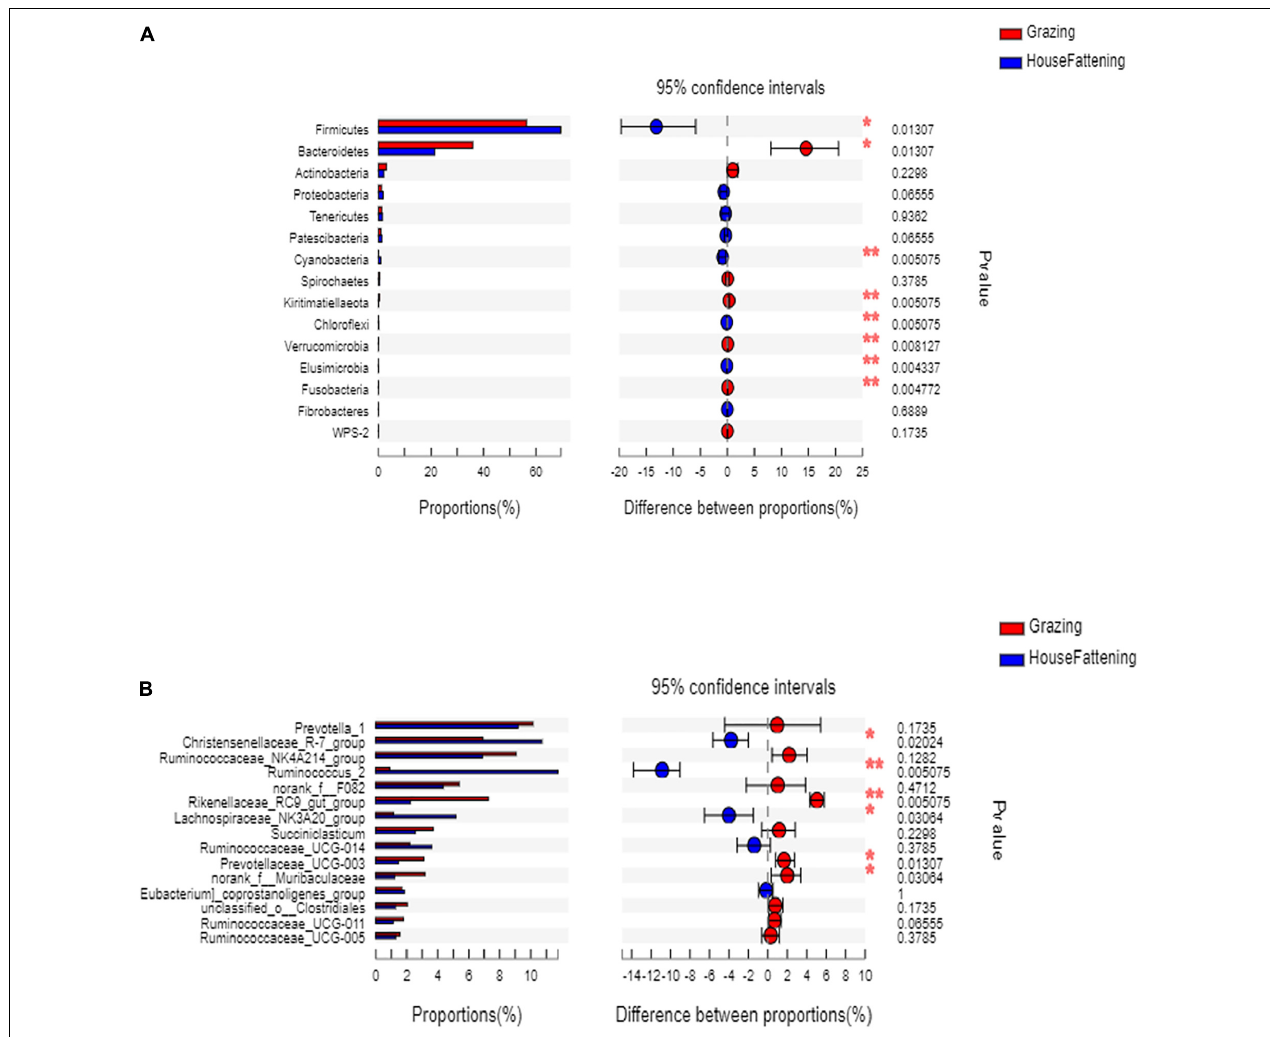
FIGURE 3 | (A) The bacteria with significant differences between two feeding systems at the phylum level; (B) The bacteria with significant differences between two feeding systems at the genus level. * P < 0.05; ** P <